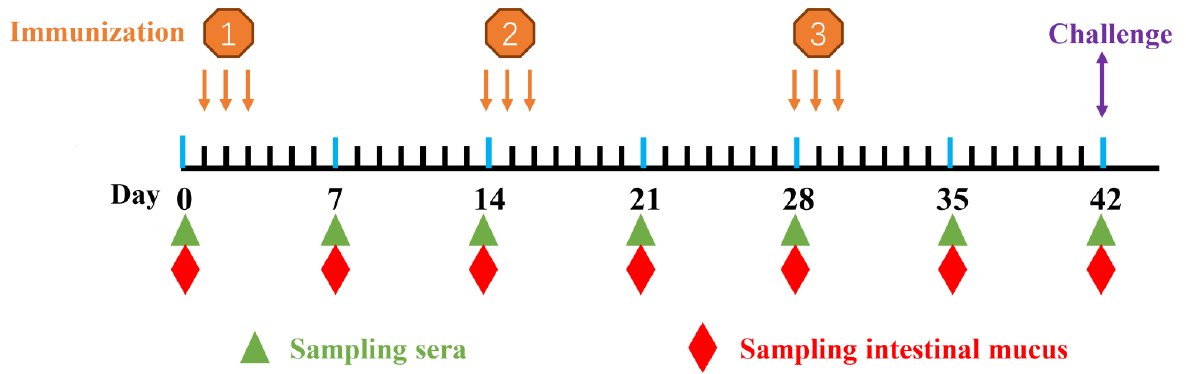
Figure 2. The oral immunization structure and schedule of sampling. The immunization was performed for consecutively three days with a 2-week interval between booster immunizations. The serum and intestinal mucus ( n = 3) were collected on days 0, 7, 14, 21, 28, 35, and 42. The challenge test was carried out on day 42 post-immunization.